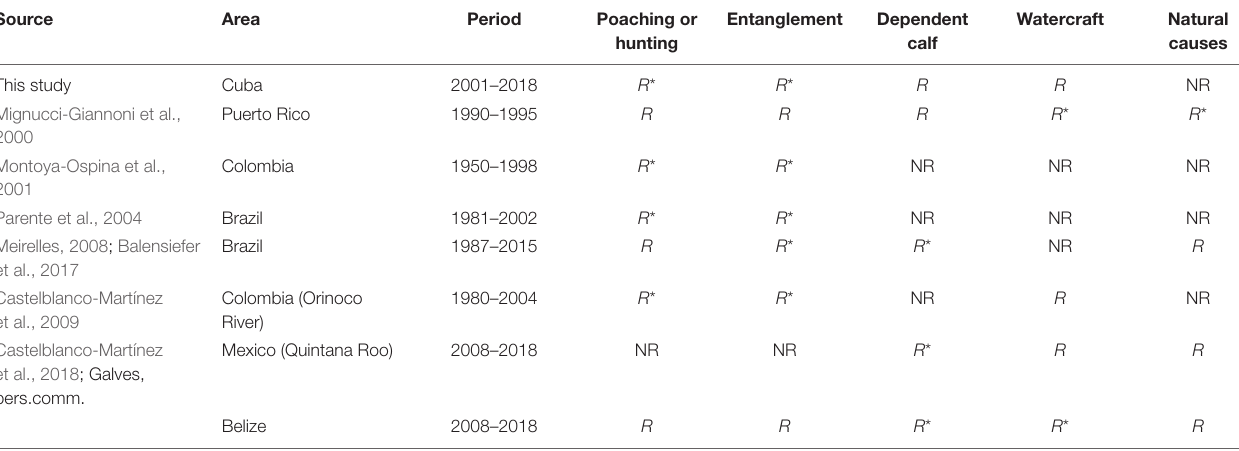
TABLE 6 | Information about mortalities of Antillean manatees in six populations.